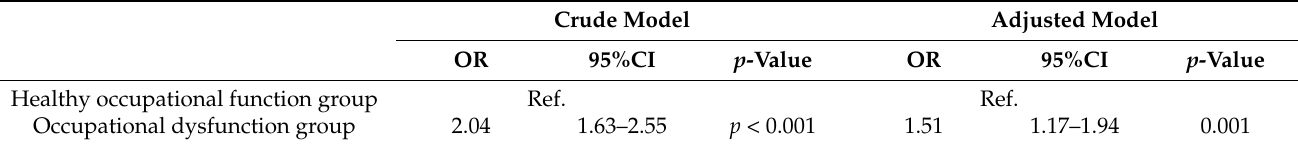
Table 2. Association between occupational dysfunction and social